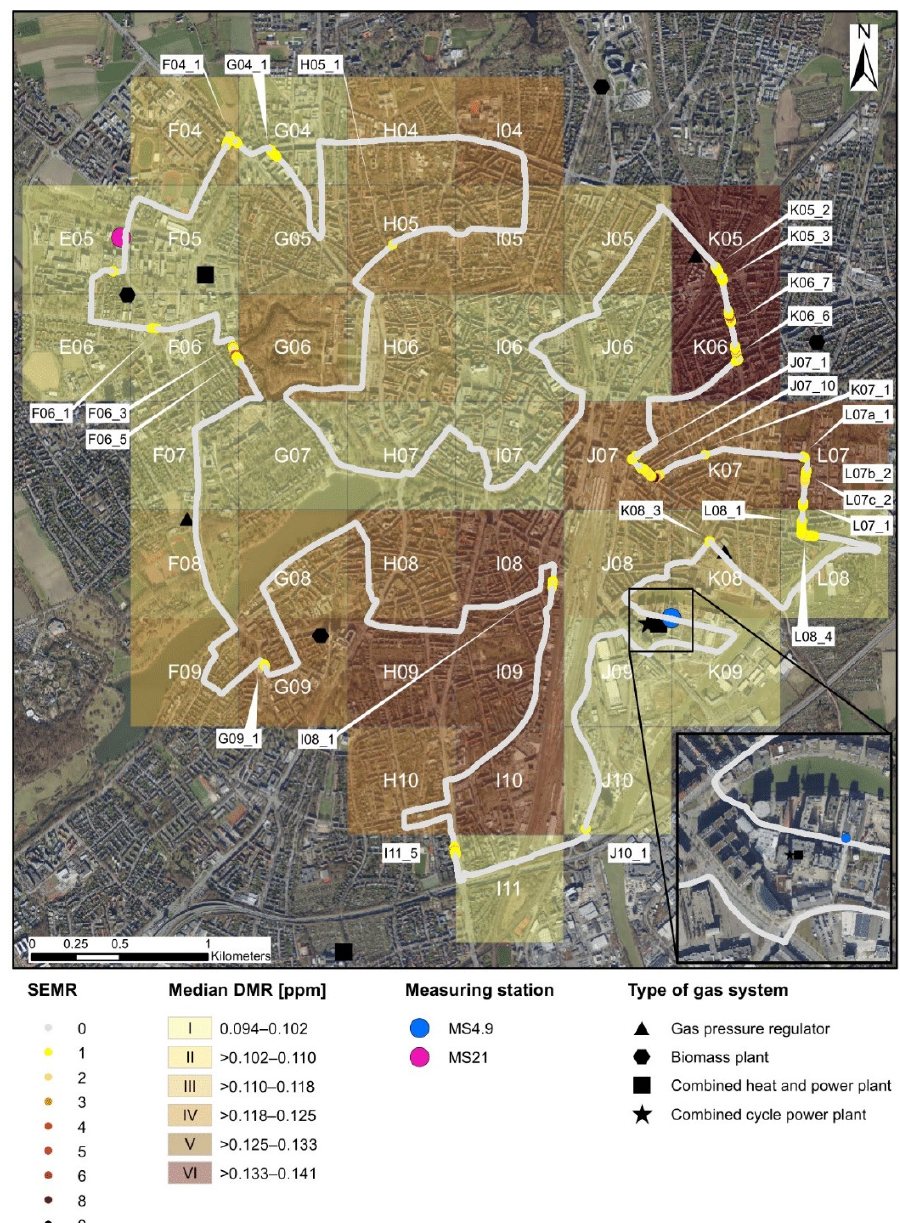
Figure 3. Overview of the route showing locations with occurrence of elevated mixing ratios (EMR) with indication of the sum of elevated mixing ratios (SEMR) and quadrant medians of the differential mixing ratio (DMR); Map source: DOP, © Geobasis NRW 2017, DL-DE->Zero-2.0, (http://www.govdata.de/dl-de/zero-2-0, accessed on 1 November 2021). URL: https://www.bezreg-koeln.nrw.de/brk_internet/geobasis/webdienste/geodatendienste/index.html (accessed on 1 November 2021); Locations of gas systems: MULNV NRW [54] and own sightings.